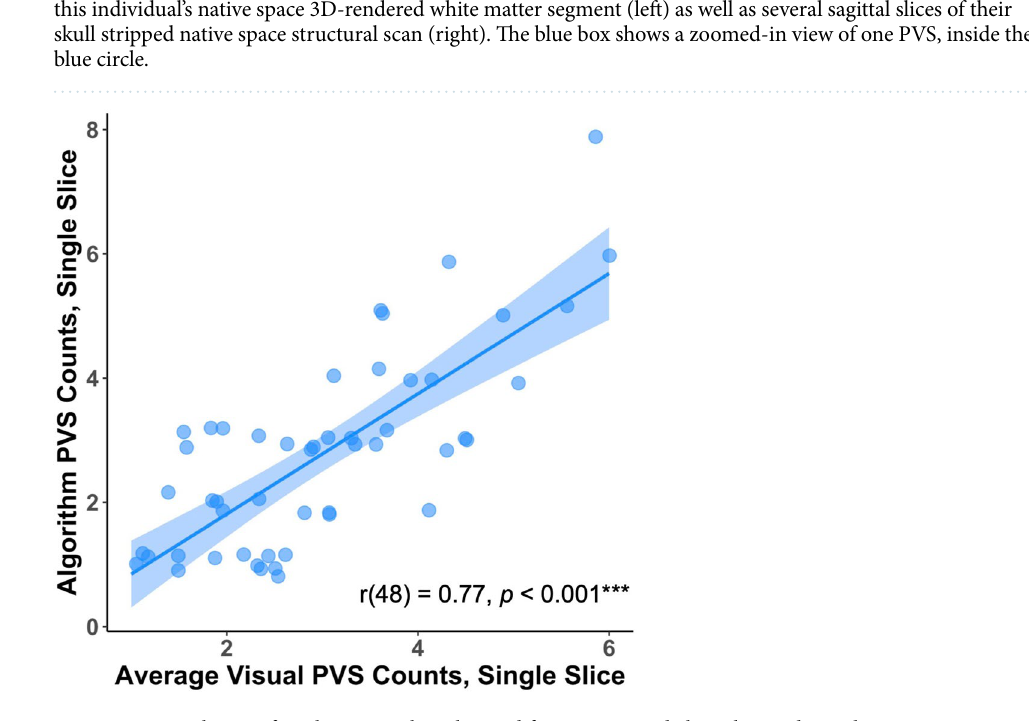
Figure 2. Correlation of total PVS number obtained from automated algorithm and visual rating. Here we depict the strong positive correlation between the algorithm-generated total PVS number, and the average total PVS number (on the same slice for each participant), as counted by two blinded independent raters for 50 randomly selected MRI scans from this astronaut cohort. Note that points are jittered by x = 0.15 and y = 0.15, for ease of visual interpretation (as otherwise, many points would be overlapping with one